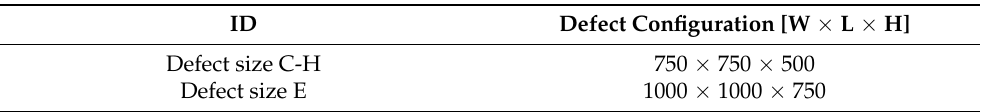
Table 2. Defect scenario configuration for Ti6Al4V samples with a variation in the defect height. Dimensions are reported in µ